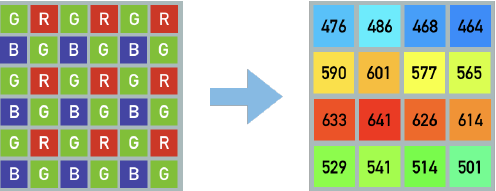
Figure 3. Illustration of common Bayer pattern RGB mosaic and spectral filter array with 16 different peak wavelengths [nm] equally distributed over the whole sensor. The indicated spectral sensitivity peaks show the sensor implementation available for this